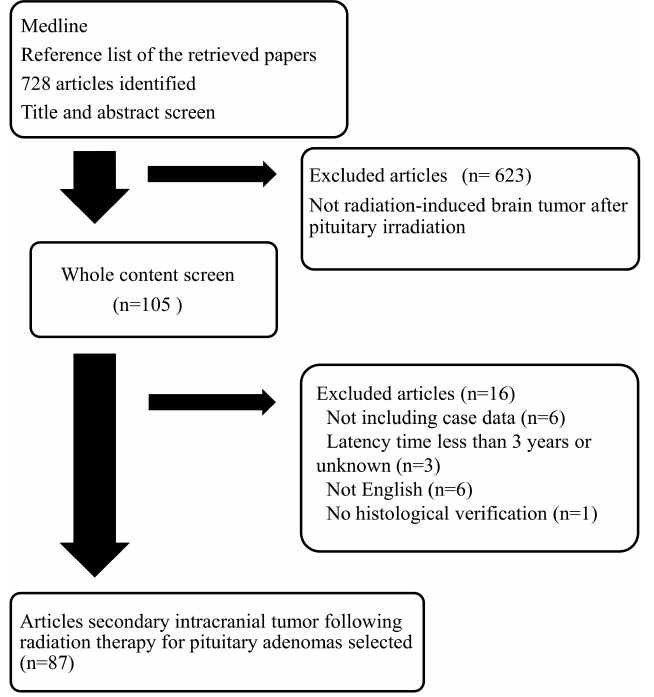
Figure 1. Flowchart of the selection process for studies included in the meta-analysis. Table 1. Characteristics of secondary tumor, Average (95% CI).